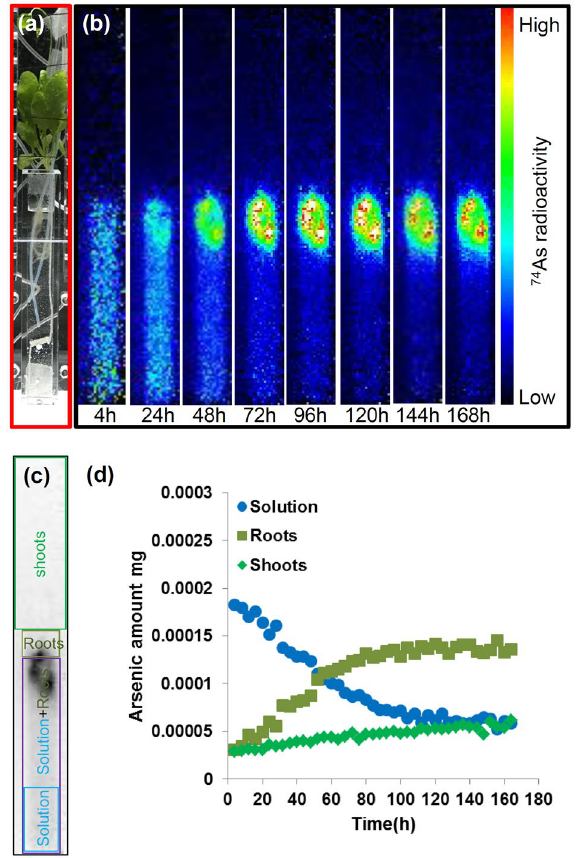
Figure 3. Serial images of 74 As behavior and time course of the amount of As in different regions of A . thaliana . ( a ) Photograph of test plant in the experimental apparatus. The solid red rectangles indicate the field of view of the PETIS during the plant imaging. ( b ) Serial images of the A . thaliana (0–168 h). Each frame was created from the integration of original images collected every 5 min. ( c ) Examined regions in the plant. The blue rectangle indicates the region of the solution, the purple rectangle indicates the solution with the roots inside, the yellow- green rectangle indicates the roots above the solution and the green rectangle indicates the shoots. ( d ) The time course of the amount of As in the regions shown in ( c ) fed with 0.2 μM AsV including 2 kBq of 74 As-labeled